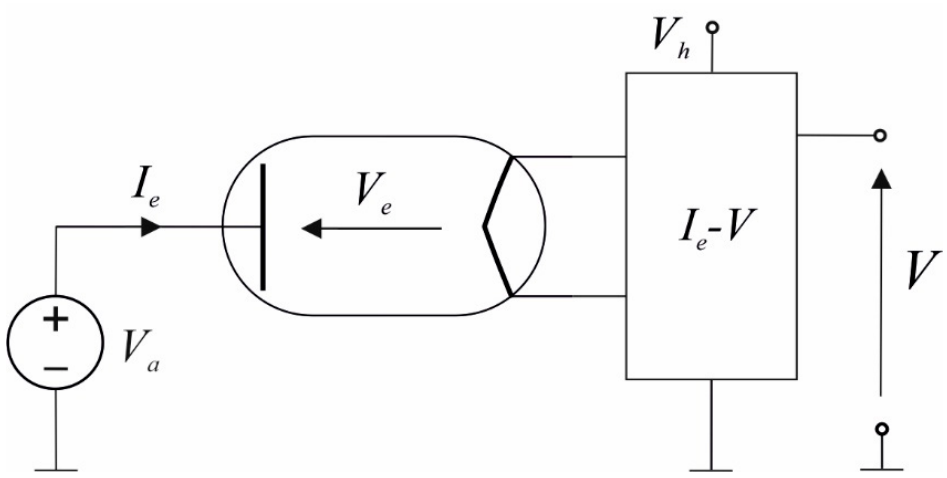
Figure 9. Scheme of the measuring system for determining the static characteristic of the I e - V . Regulated voltage V h is supplied with LPS-305 (Motech Industries INC.), V a = 100 V is supplied with CPX400DP (Aim TTi).